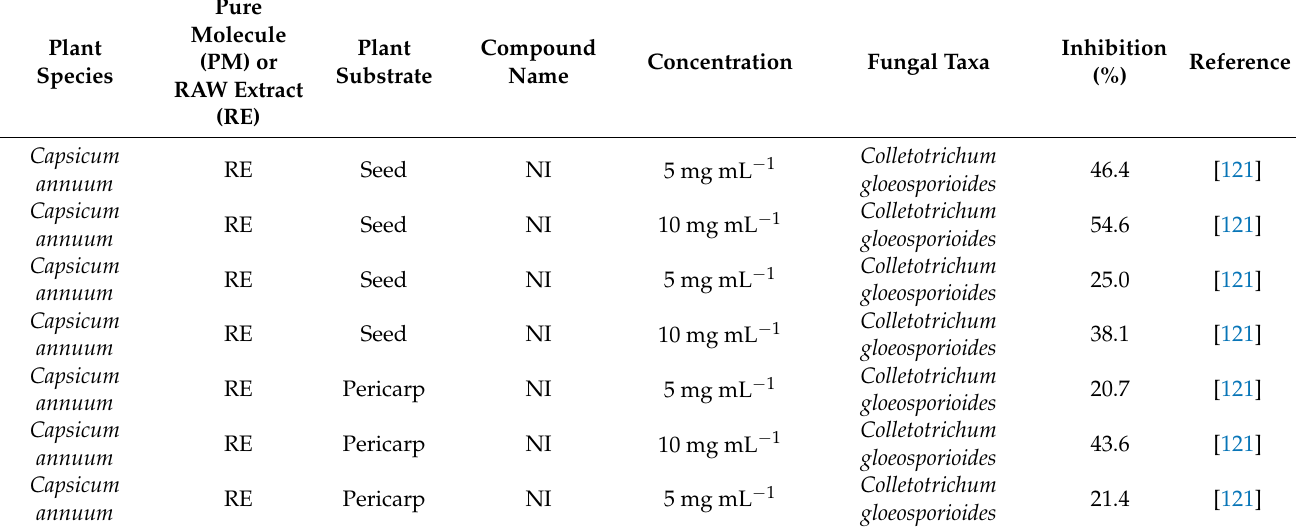
Table 1. In vitro analysis of antifungal activities of capsaicinoids and capsinoids as pure molecules or pepper